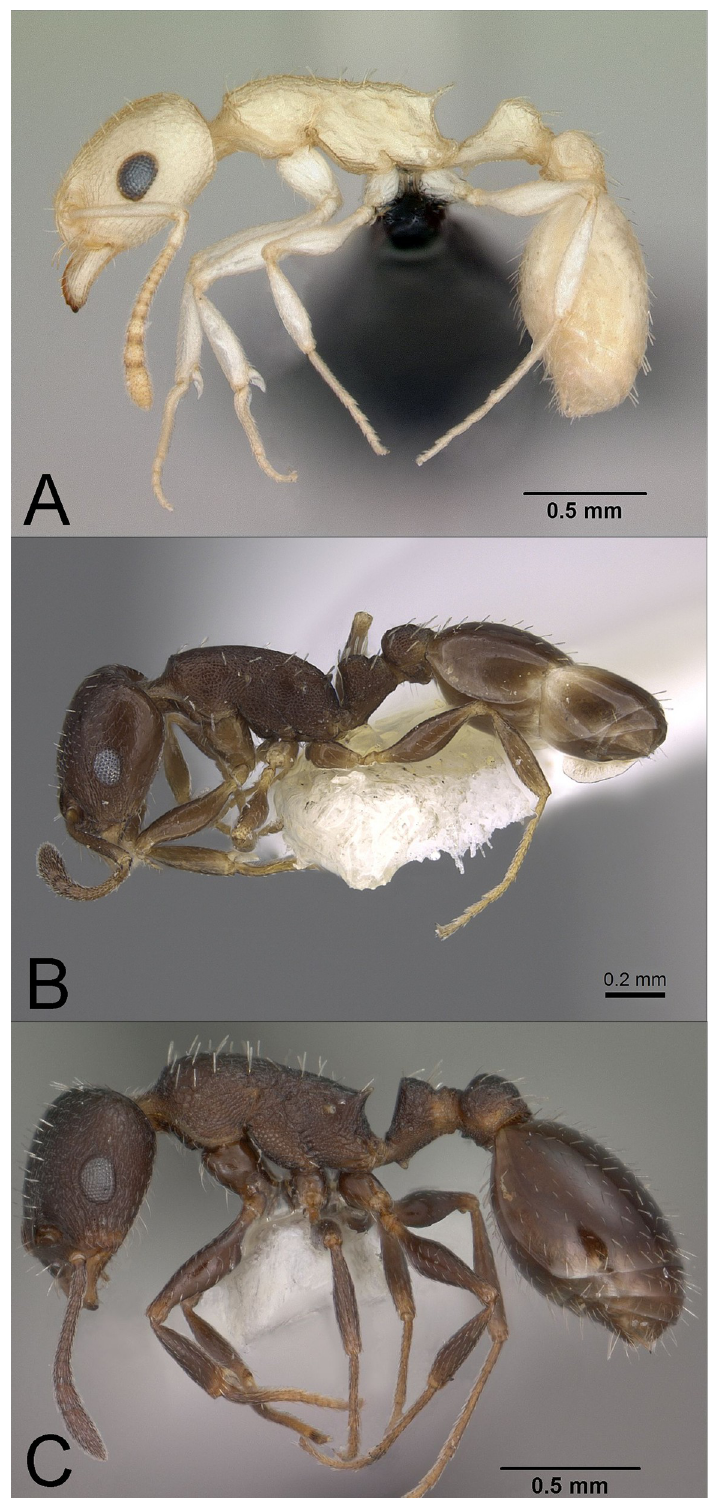
Fig 3. Profile photographs of pale (A) and dark species (B–C) (see text) of Temnothorax (subfamily Myrmicinae) examined in this study: ( A ) T . sp. BCA-5 (CASENT0118165), ( B ) T . neomexicanus (CASENT0923368), and ( C ) T . tricarinatus (CASENT0102845). Note the relatively larger eyes of pale compared to dark species. Photographs by Michele Esposito from www.antweb.org. https://doi.org/10.1371/journal.pone.0257779.g003 PLOS ONE | https://doi.org/10.1371/journal.pone.0257779 September 22,